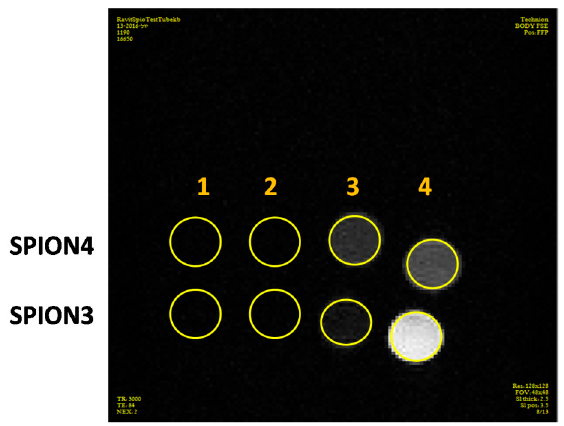
Figure 15. In vitro MRI T2w scans of samples SPION3 and SPION4. ( 1 ) Original sample; ( 2 ) 2-fold dilution; ( 3 ) 10-fold dilution; and ( 4 ) 50-fold dilution.